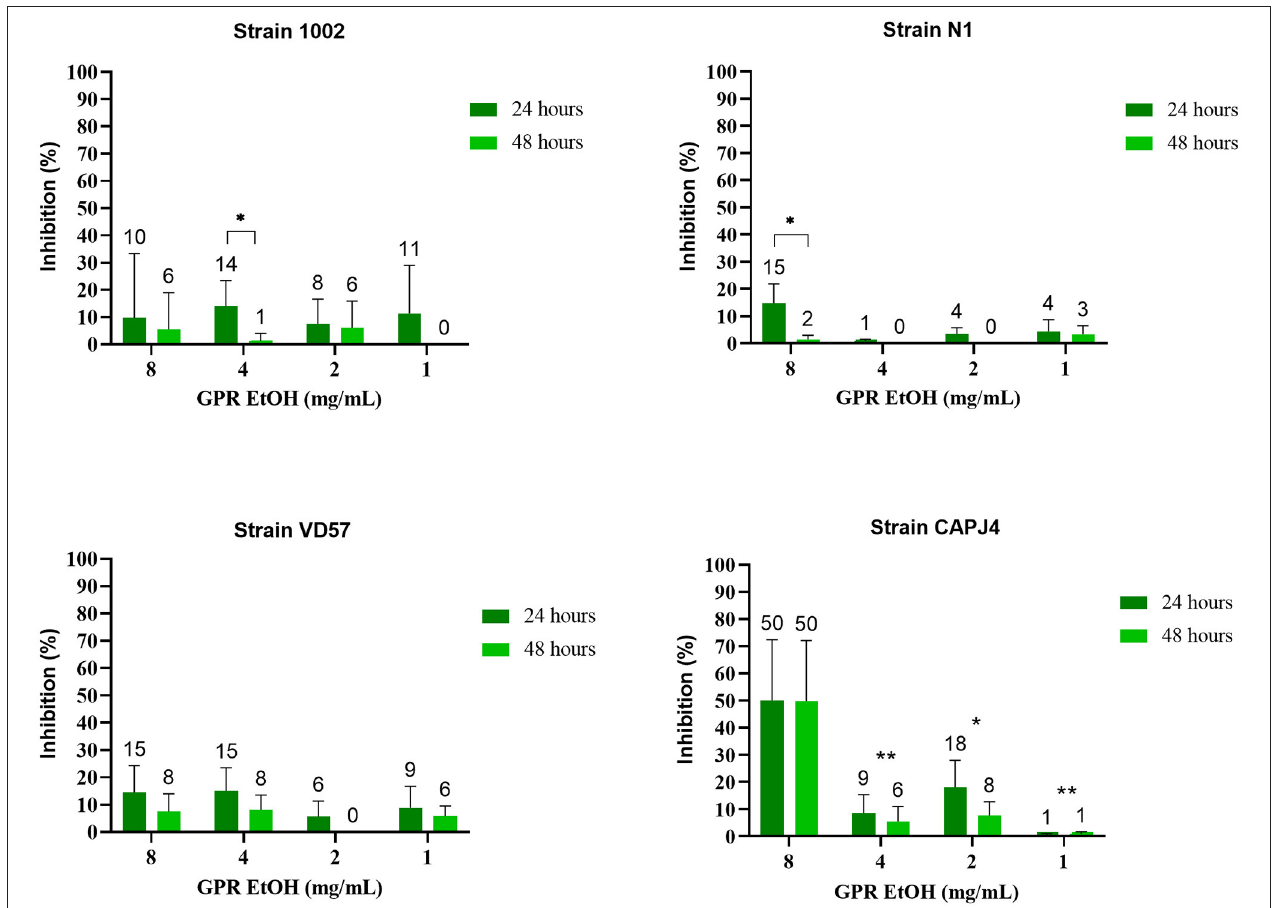
FIGURE 2 | Activity of the green propolis ethanolic extract (GPR EtOH) in the C. pseudotuberculosis consolidated biofilm. The bars represent the standard deviation of three independent experiments. The values above the bars represent the average value of consolidated biofilm disruption (%). The asterisks indicate statistical differences between the bacterial cells treated with different concentrations of propolis extracts at different times, analyzed by one-way ANOVA and t -test. * p = 0.02; ** p < 0.006.